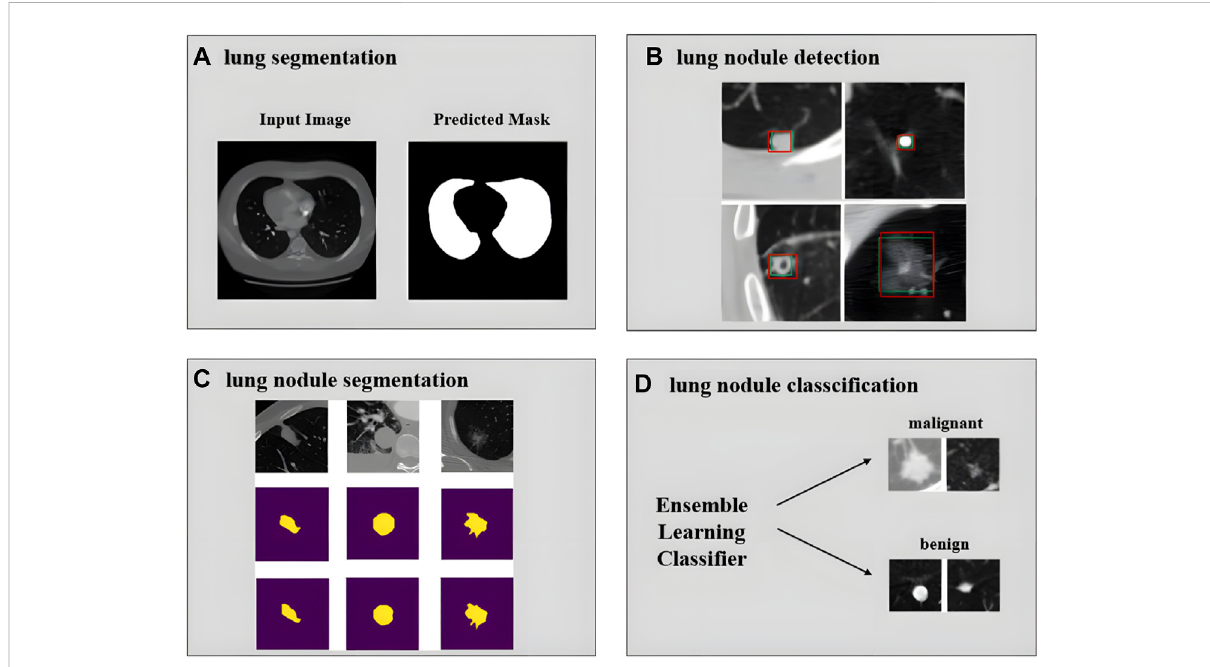
FIGURE 9 Achievements related to the realization of pulmonary nodule CAD system. (A) Input image and predicted mask for lung segmentation (adapted and modi fi edfrom Tan et al., 2020). (B) Lung nodule detection results using deep learning. The greenrectangle box represents ground truth and the red rectangle box represents the detection results (adapted and modi fi ed from Cao et al., 2019). (C) Segmentation results of large nodules, the fi rst row is the original image, the second row is the radiologist ’ s manual annotation results, and the third row is the result of the network prediction (adapted and modi fi ed from Shi et al., 2020). (D) Classi fi cation of lung nodules into malignant and benign using an ensemble learning classi fi er (adapted and modi fi ed from Zhang et al.,